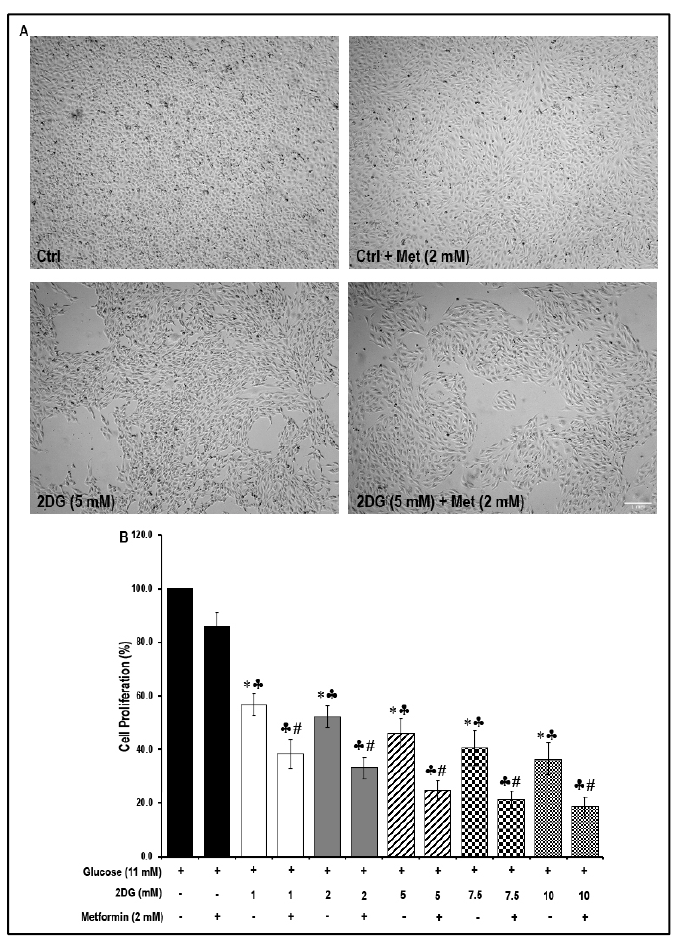
Figure 6. Morphology of MMECs during the different treatment conditions and the effect of metformin treatment on cell proliferation in normal glucose- and 2DG-exposed MMECs (48 h): Representative microscopic images ( A ; from four experiments) show the morphology of MMECs under the different treatment conditions after 48 h in culture. The bar graph ( B ) shows the rate of cell proliferation in MMECs treated with varying concentrations of 2DG with or without metformin (2 mM), after 48 h in culture. Non-treated cells and cells treated with metformin (2 mM) alone were used as suitable controls. * p < 0.05 was considered significant when compared to non-treated controls, ♣ p < 0.05 was considered significant when 2DG treatment was compared to the metformin (only)-treated cells. # p < 0.05 was considered significant when the combination treatment, 2DG + Met, was compared to is respective 2DG (only)-treated cells. For example, # p < 0.05 was considered significant when; 2DG (1 mM) + Met (2 mM) was compared to 2DG (1 mM); 2DG (2 mM) + Met (2 mM) was compared to 2DG (2 mM); 2DG (5 mM) + Met (2 mM) was compared to 2DG (5 mM). Scale bar = 1000 μ m.